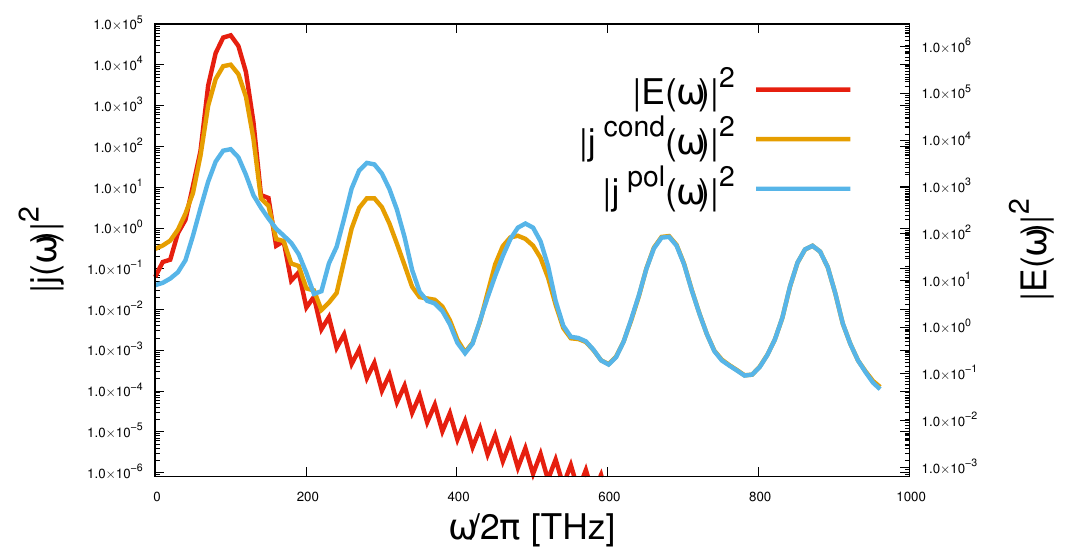
Figure 14. Periodograms for the pulse of a periodic electric field (Figure 8) and the currents generated by it (Figure